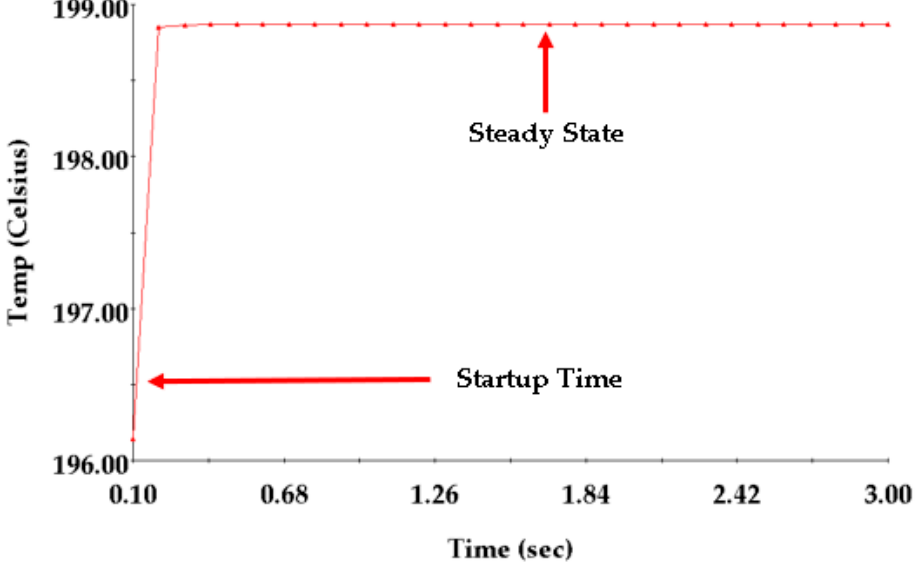
Figure 8. Temperature vs. time probe profile plot at the first electrode for 7 A without a heat sink and proper cooling.